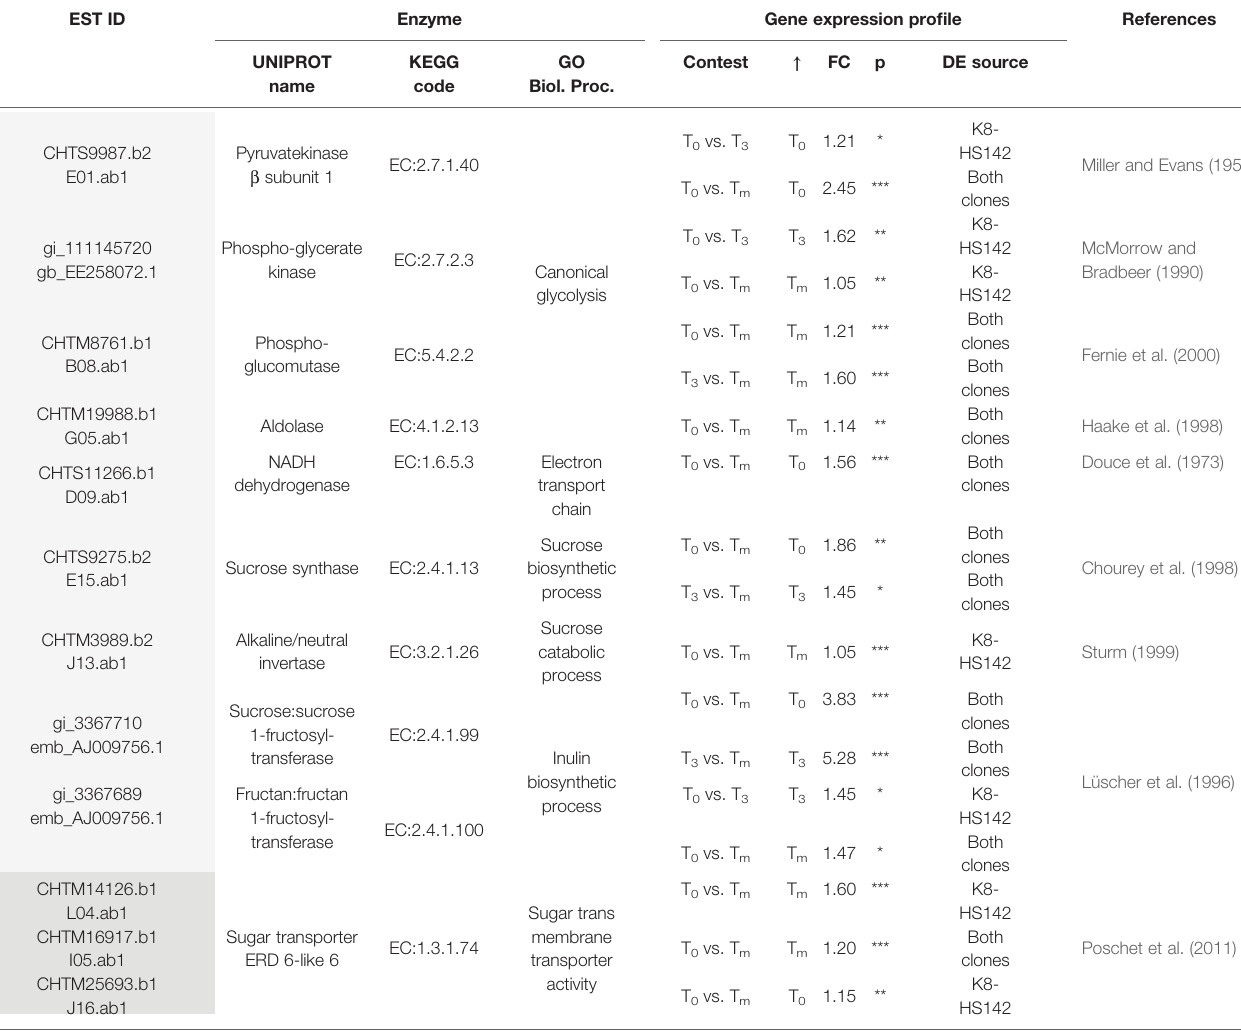
TABLE 6 | Differentially expressed (DE)/expressed sequence tags (ESTs) between tuber stages taking a role in the carbohydrate metabolism and sugar transport. EST ID Enzyme Gene expression pro fi